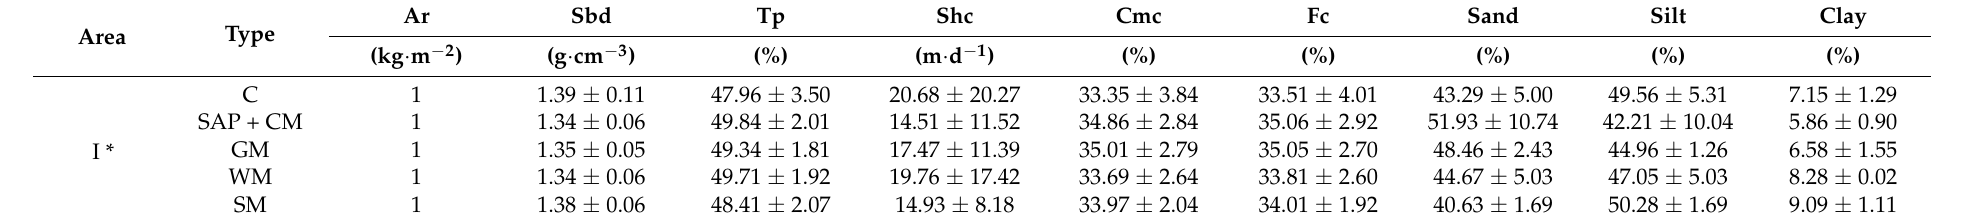
Table 3. Average (avg) and standard deviation (SD) values of some soil physical properties computed for each mulch. Here, the effective use of soil mulching in the karst region of southern China is shown, reporting the following types of soil conservation techniques: ( a ) control (C), ( b ) super-absorbent polymer + cobblestone mulching (SAP+ CM), ( c ) grass mulching (GM), ( d ) inner shell of walnut mulching (WM), ( e ) straw mulching (SM). Direct comparisons were made for each mulching during the rainy season in 2022. The variables compared were the following soil moisture constants: ( a ) mulch application ratio (i.e., specific value) (Ar), ( b ) soil bulk density (Sbd), ( c ) total porosity (Tp), ( d ) saturated hydraulic conductivity (Shc), ( e ) capillary moisture capacity (Cmc), ( f ) field capacity (Fc), ( g ) s and, ( h ) silt, ( i ) clay. The method used to obtain these data is the ring knife method. The depth of the soil layer to obtain these data is 0–180 cm.